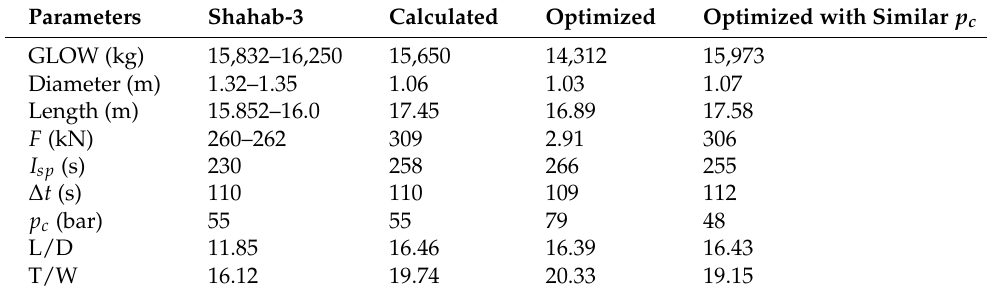
Table 6. Comparison of Shahab-3 performance parameters and dimensions with the research